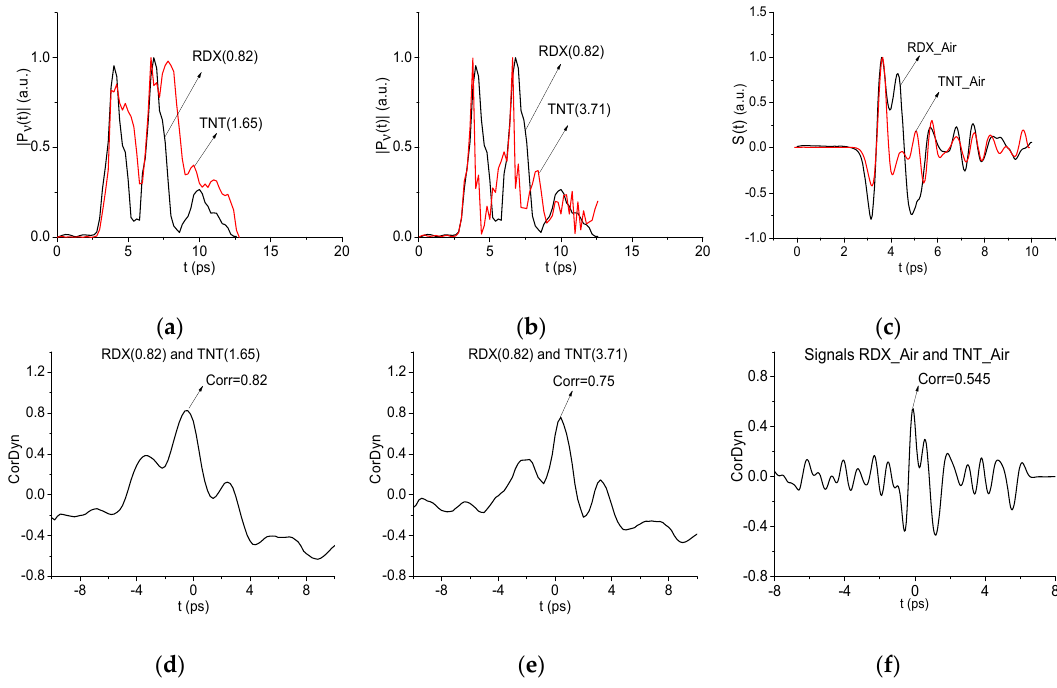
Figure 11. Normalized spectral line dynamics RDX (0.82), TNT(1.65) ( a ), RDX (0.82), TNT(3.71) ( b ); standard THz signals RDX_Air and TNT_Air ( c ); correlation coefficient between spectral line dynamics RDX(0.82) and TNT(1.65) ( d ); RDX(0.82), and TNT(3.71) ( e ); between standard signals RDX_Air and TNT_Air ( f ).